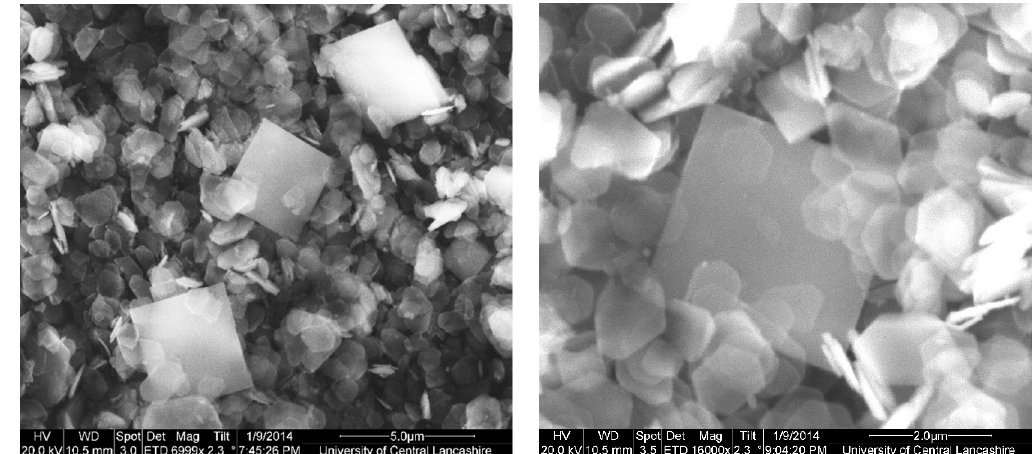
Figure 3. SEM images for mixed-phase 30% conventional Y–ZrP showing Y–ZrP as hexagonal particles and tetragonal particles indicating a second phase of YPO 4.